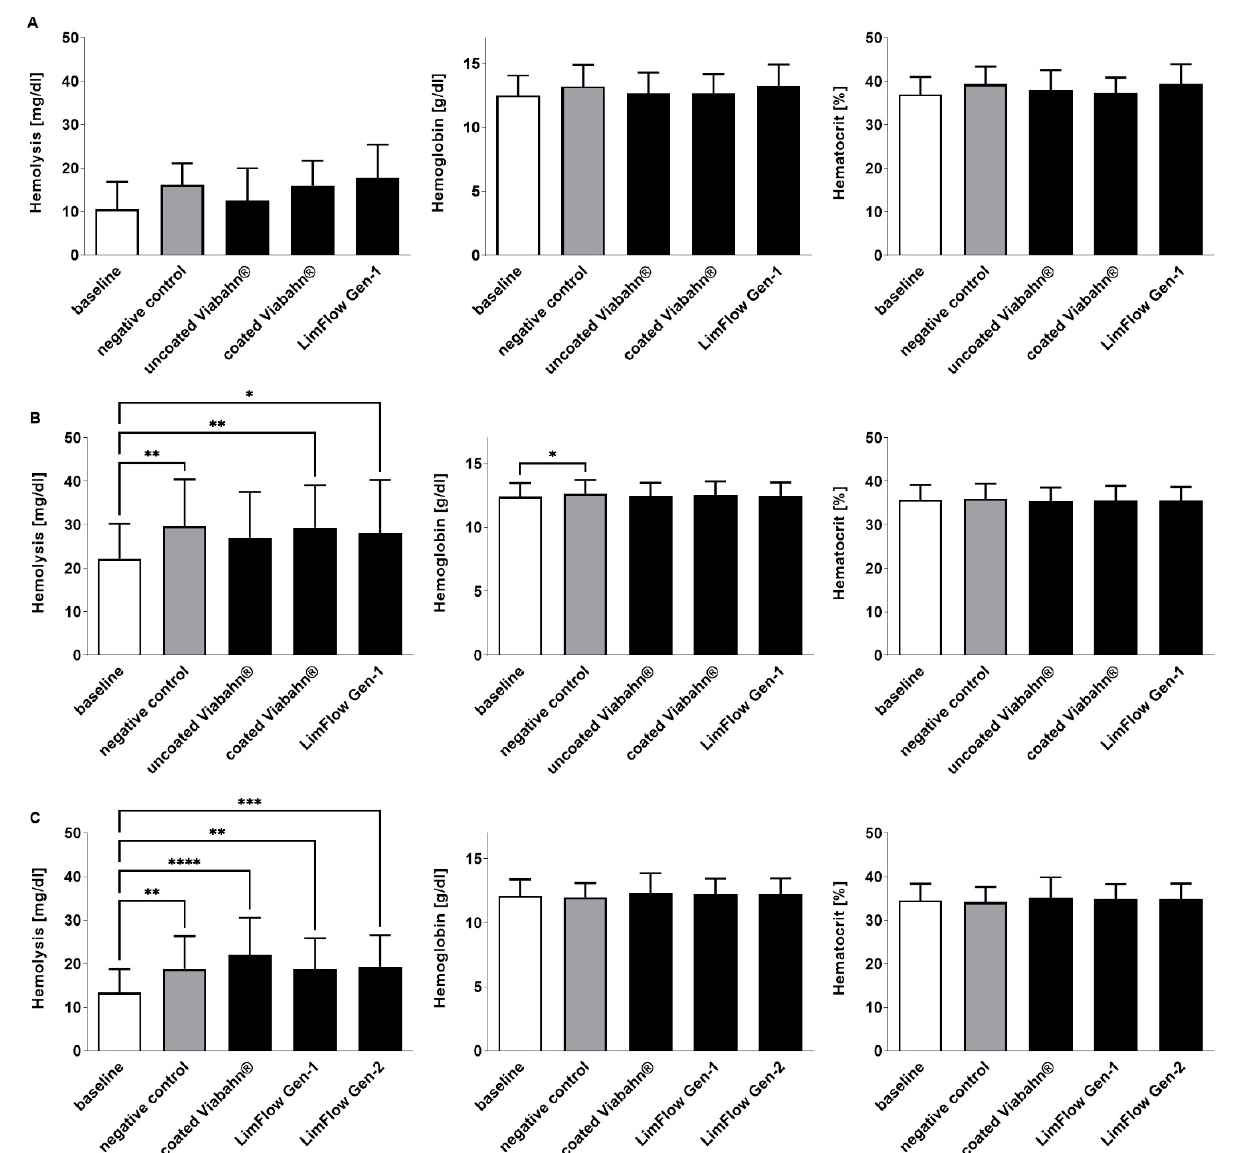
Figure 7. Analysis of hemolysis, hemoglobin, and hematocrit levels after the incubation of fresh human blood with test items for 60 min at 37 °C. ( A ) Pilot study ( n = 3), ( B ) Study B ( n = 8), ( C ) Study C ( n = 8). Whole human blood without incubation and contact to test material served as baseline, and blood without test material, but with incubation as the negative control. The data are shown as mean + SD. Statistical di ff erences were determined using one-way ANOVA for repeated measurements followed by Bonferroni’s multiple comparison test. (* p < 0.05, ** p < 0.01, *** p < 0.001, **** p < 0.0001).